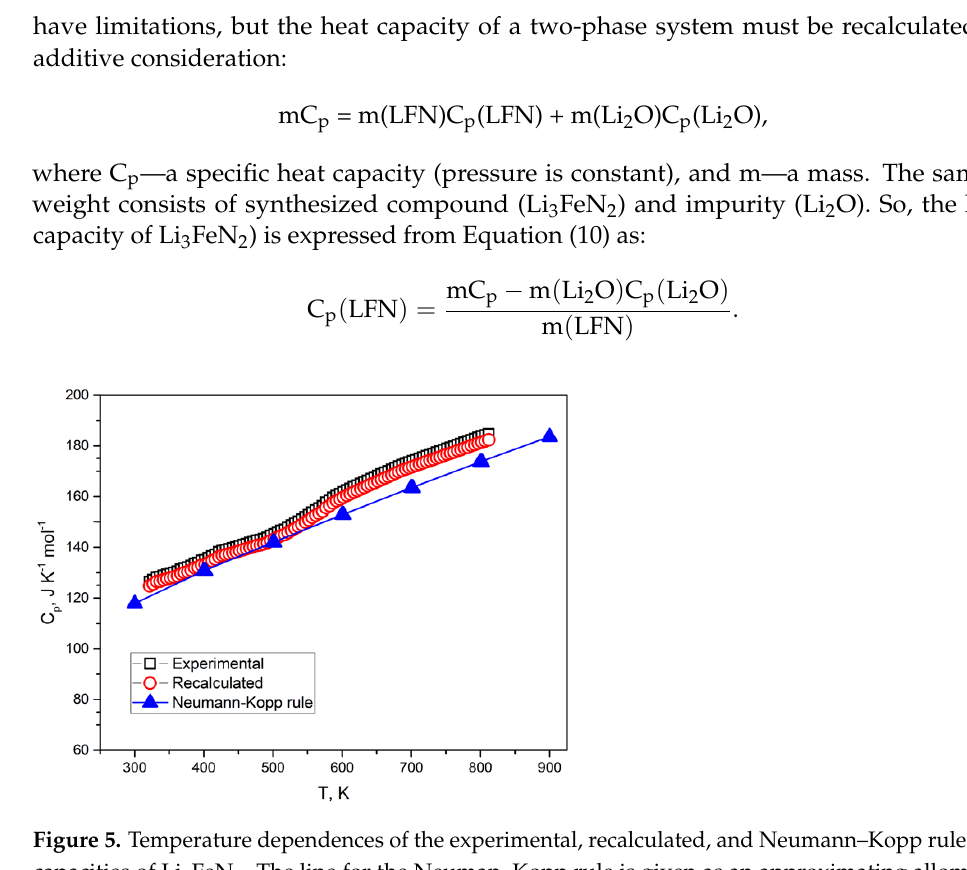
Table 5. The temperature dependence of the experimental (exp.), recalculated by Equation (14) (rec.), and calculated by the Neumann – Kopp (N-K) rule (Equation (17)) heat capacities (Cp) of Li 3 FeN 2 (s).